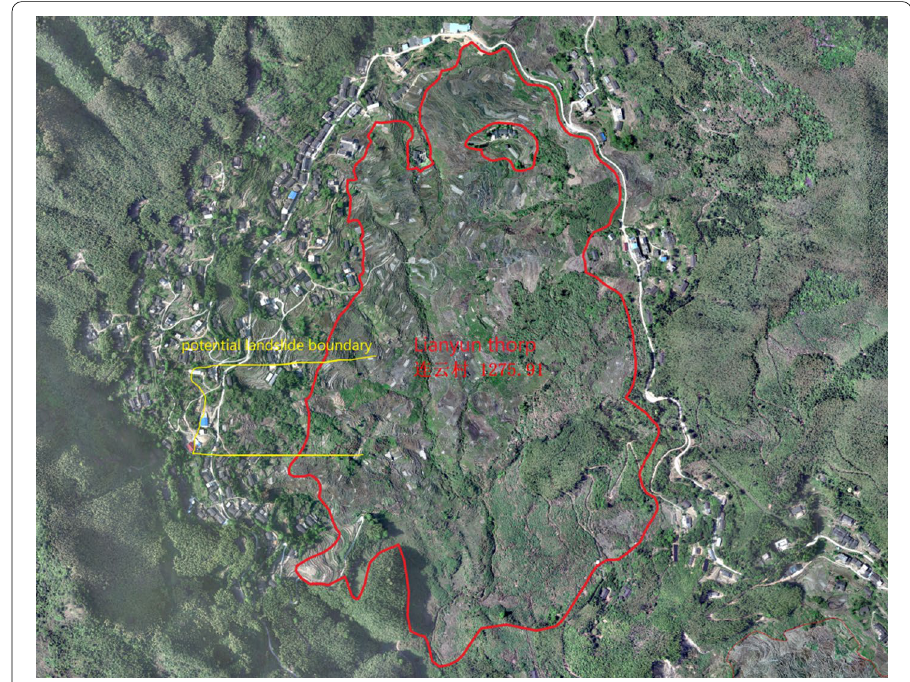
Fig. 2 Satellite topographic map of the Lianhe terraces